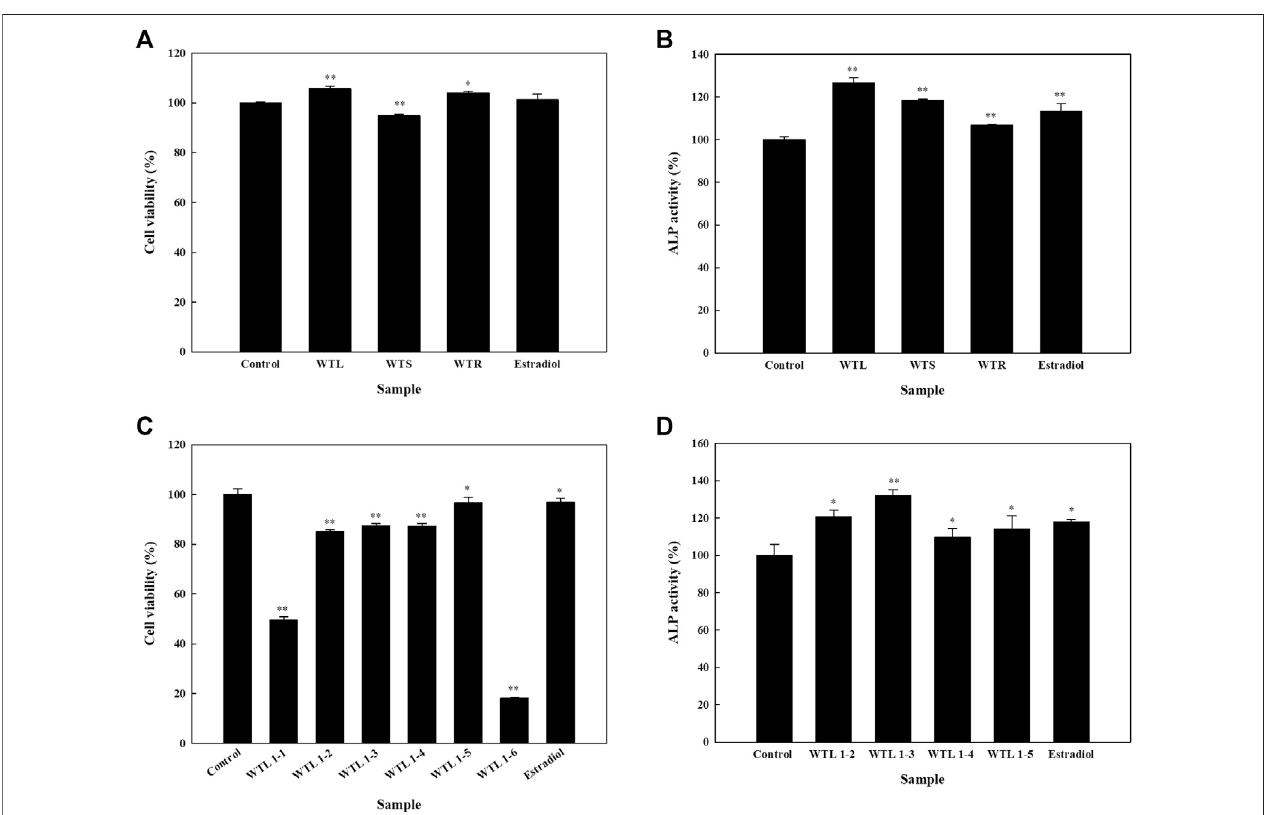
FIGURE1| Effectsofcrudeextractsofvariouspartsof Wikstroemiataiwanensis andfractionsfromtheactiveextractoncellviabilityandalkalinephosphatase(ALP) activityofhumanosteoblastcells.Cellswereseededin96-wellplates,andafter24 h,samples(100 μ g/ml)wereadded. (A) Cellviabilityand (B) ALPactivityassayswere performedusingleaves(WTL),stems(WTS),androotsof W.taiwanensis (WTR). (C) Cellviabilityand (D) ALPactivityaftertreatingcellswiththeWTLfractionfor fi vedays. Experiments were carried out in triplicate. * p < 0.05 and ** p < 0.01; data are presented as the mean ± standard deviation.